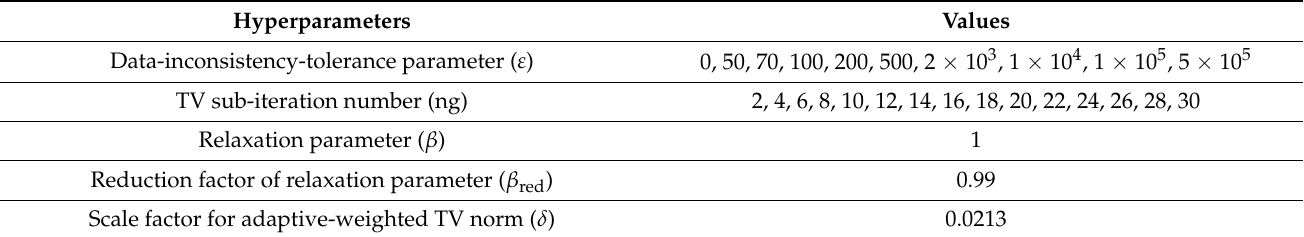
Table 1. Hyperparameter configurations for this